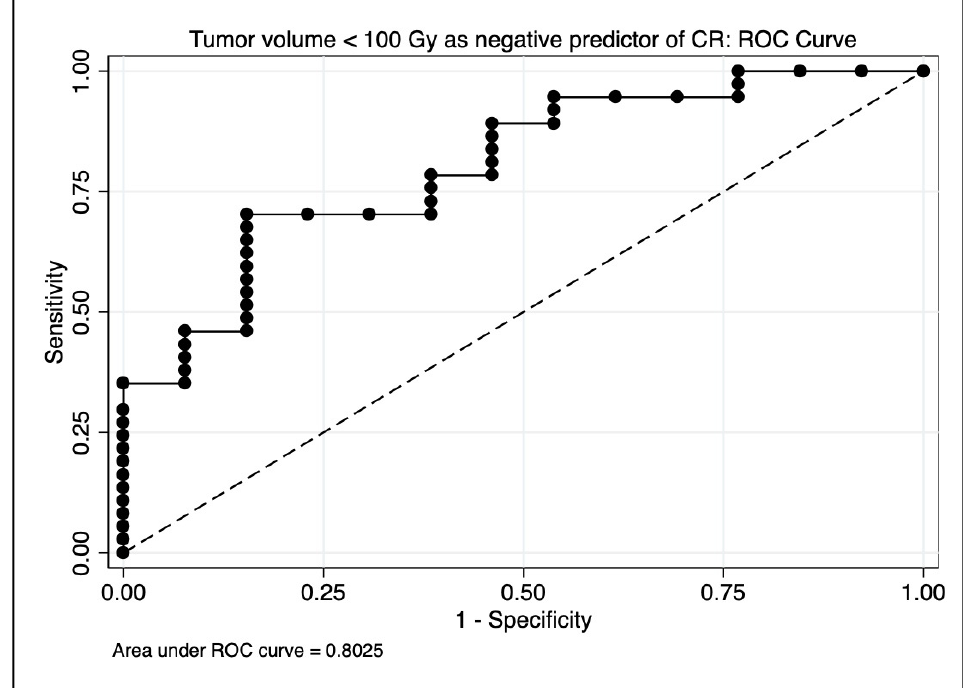
Figure 5. Area under the curve (AUC) estimate for predicting complete response on receiver operating characteristic (ROC) analysis. A model using only tumor volume receiving <100 Gy achieved an AUC estimate of 0.80.